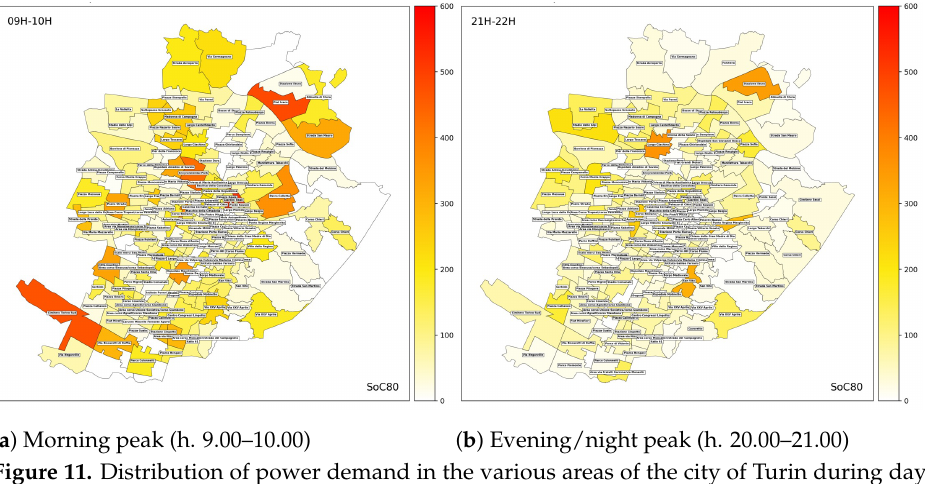
Figure 11. Distribution of power demand in the various areas of the city of Turin during daytime ( a ) and nighttime ( b ) by